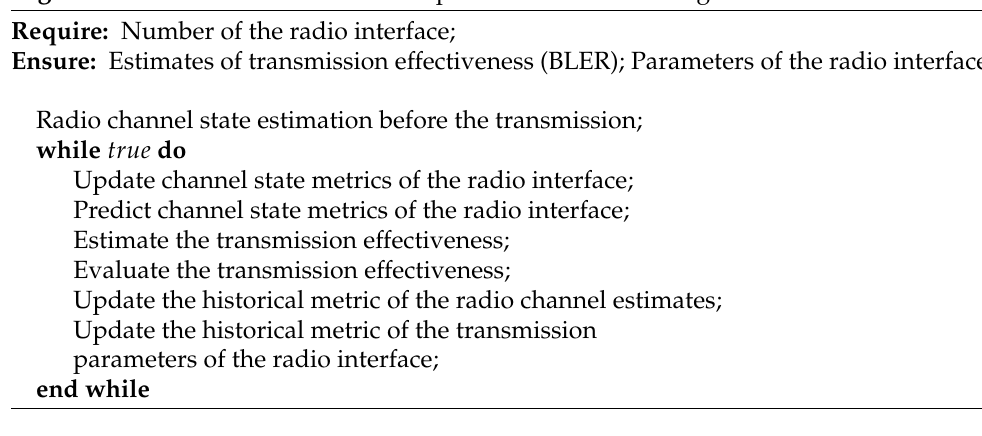
Figure 2. The block diagram of the decomposed DAA algorithm for selecting the optimal radio link. Algorithm 2 Pseudocode of the decomposed data allocation